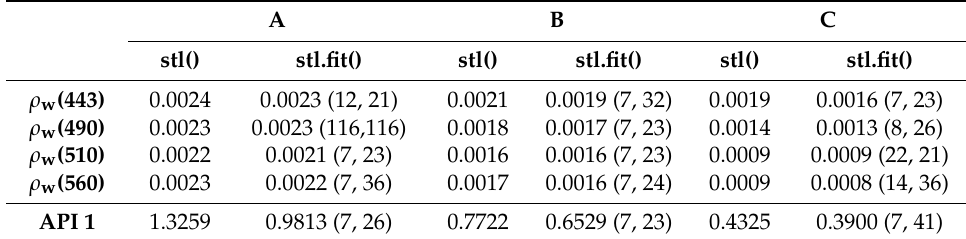
Table 1. Root Mean Square Error (RMSE) comparison between stl() and stl.fit() for water leaving reflectance ( ρ w ) between 443 and 560 nm and Algal Pigment Index 1 (API 1) (mg·L − 1 ) at Stations A, B and C. The numbers in brackets (stl.fit()), are the seasonal and trend loess smoothing parameters ( s.window and t.window ).